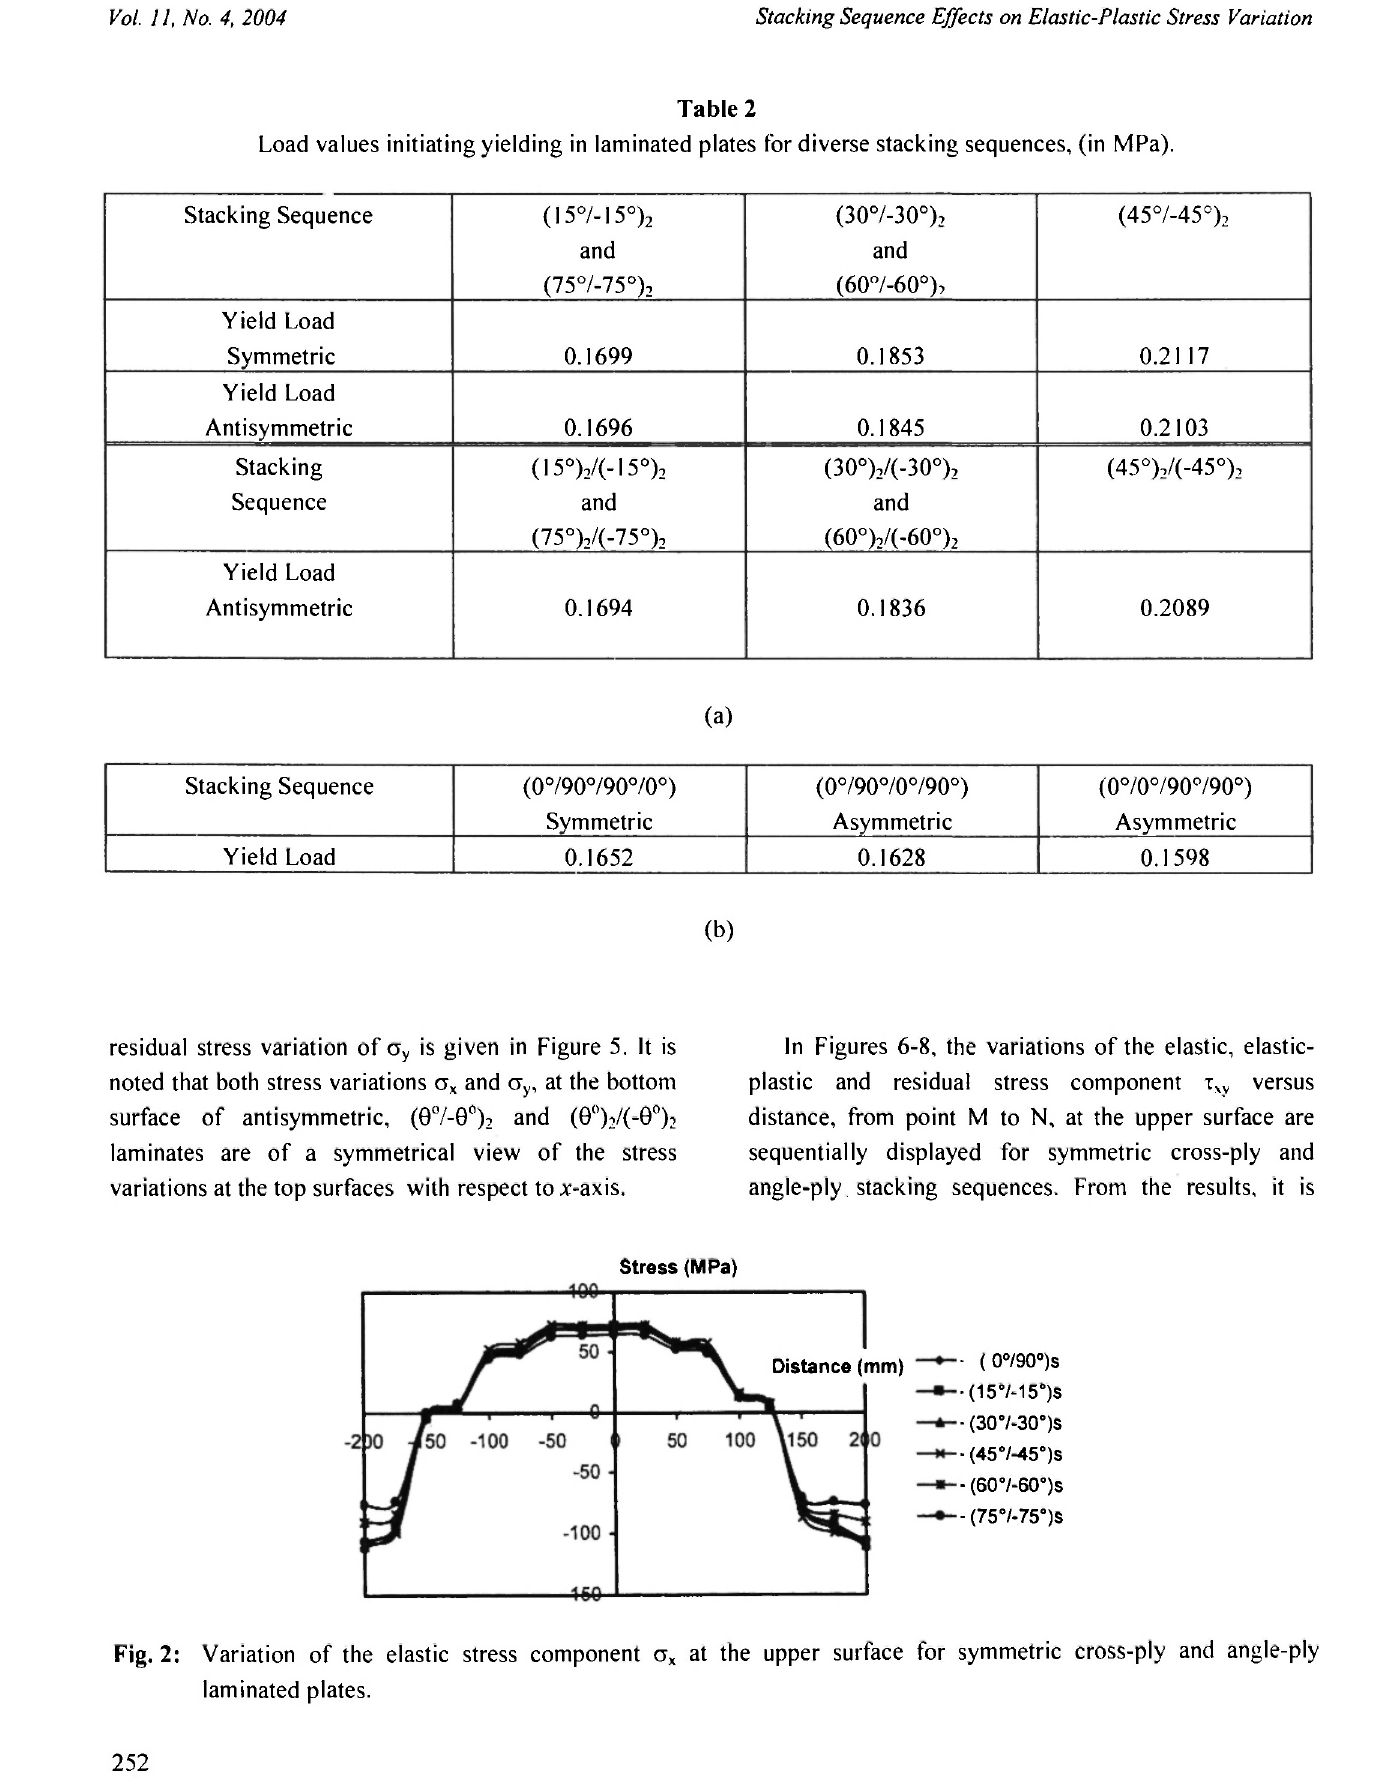
Load values initiating yielding in laminated plates for diverse stacking sequences, (in MPa).